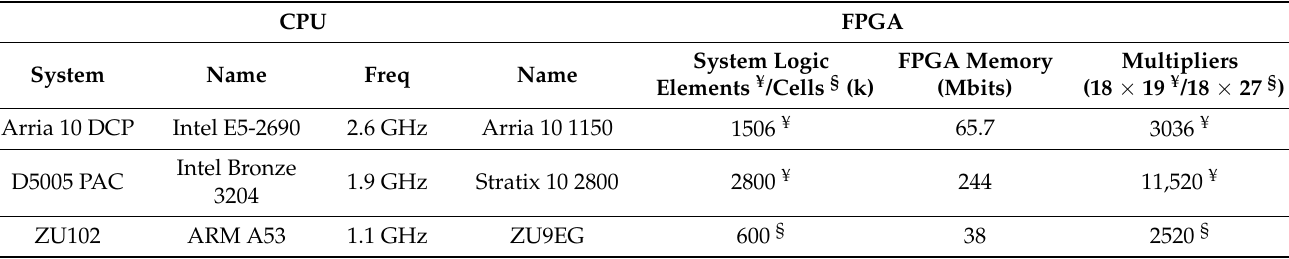
Table 1. Experimental hardware characteristics.